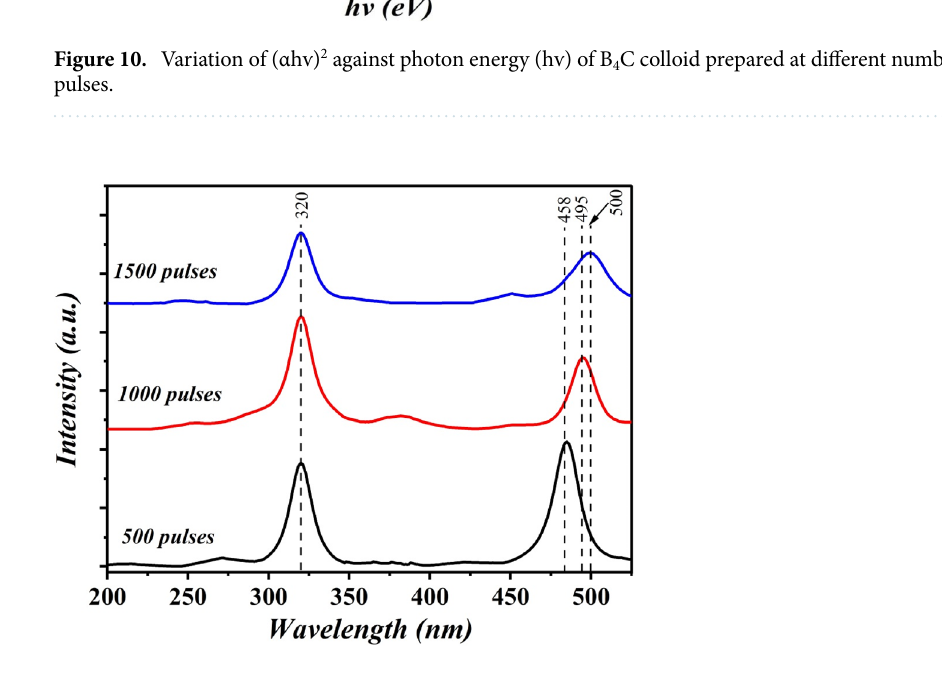
Figure 11. Fluorescence spectra of B 4 C NPs prepared at different number of laser